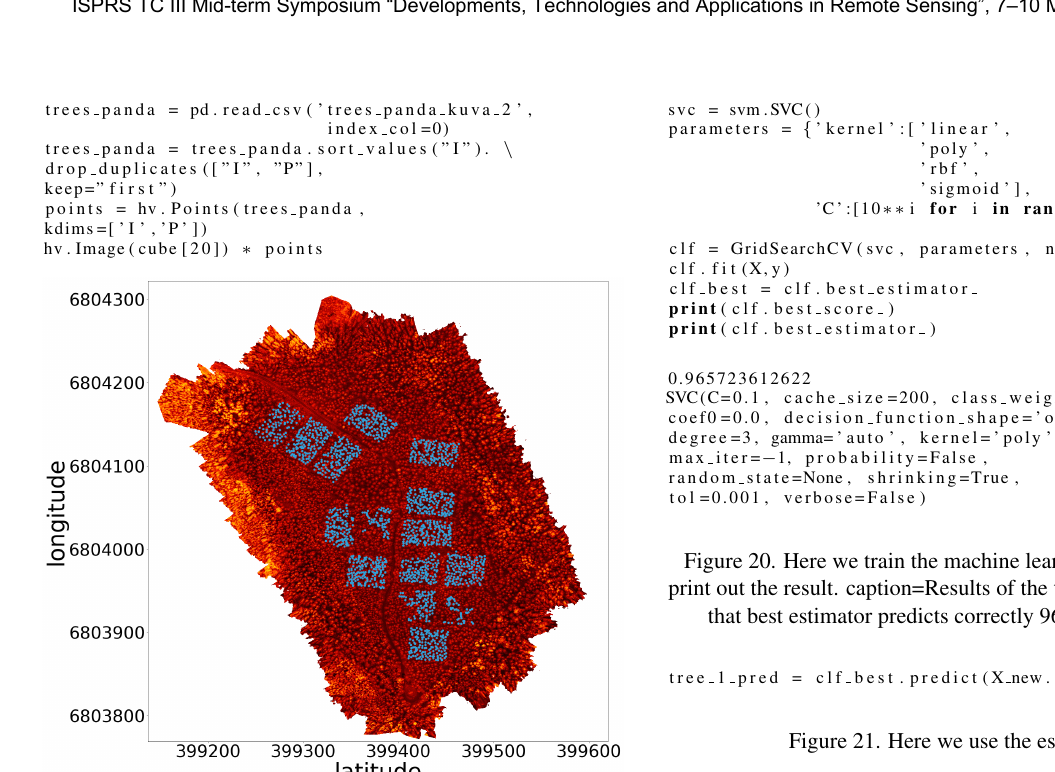
Figure 21. Here we use the